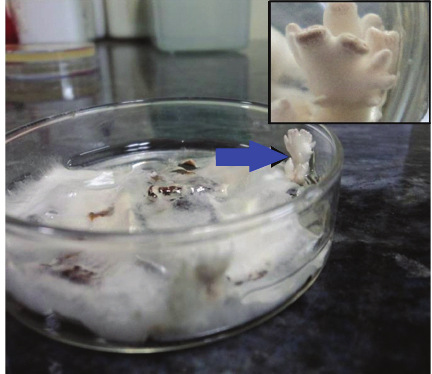
Figure 3: Fan-shaped fruiting bodies in banana peel culture (basid- iocarps).